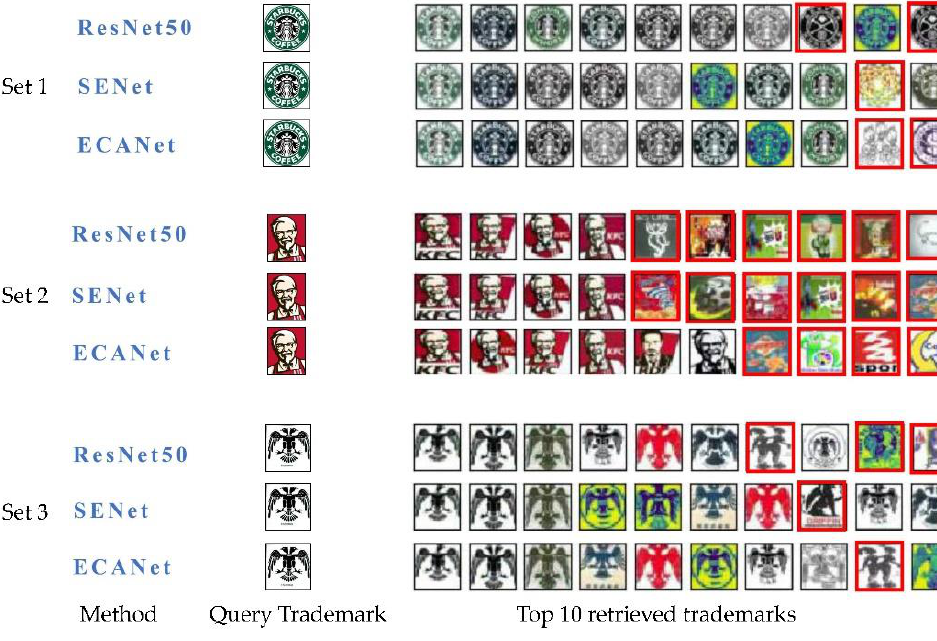
Figure 8. Comparison of trademarks retrieved by ResNet50, SENet, and ECANet.